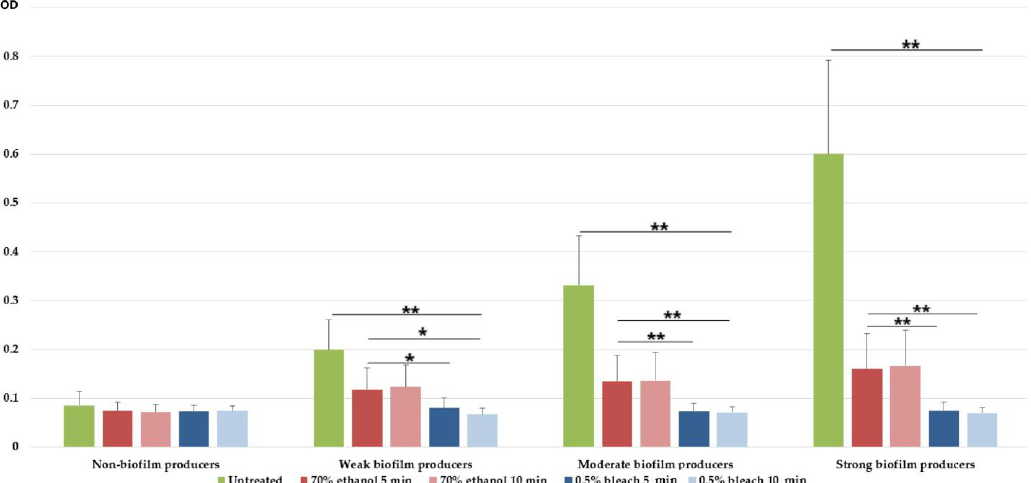
Figure 2. Eradication effect of 70% ethanol and 0.5% NaOCl on biofilm of CRAB strains. The effect was observed after 5 and 10 min of exposure for both substances. *— p < 0.05; **— p < 0.01. Biofilms are shown as mean ODs ± SD of all carbapenem-resistant Acinetobacter baumannii isolates within each biofilm capacity